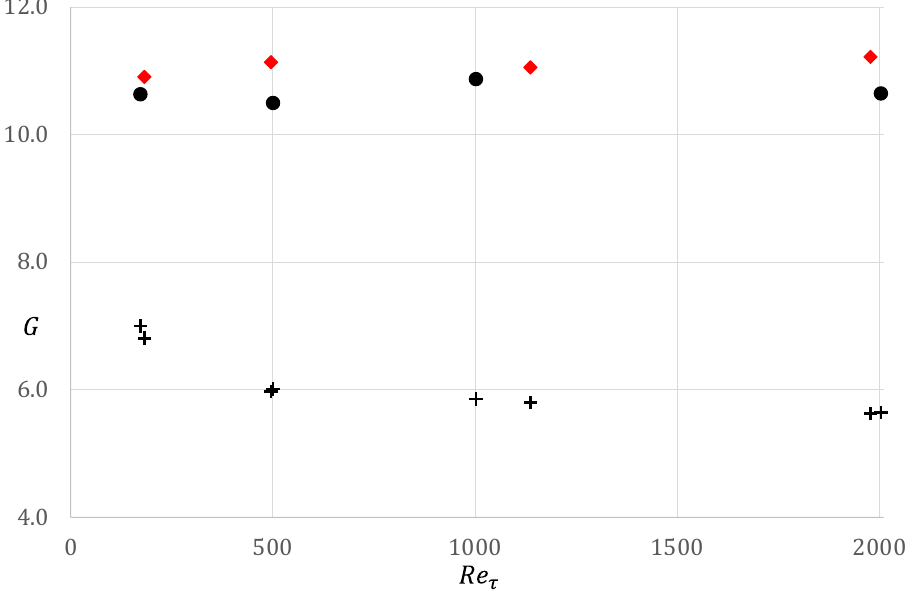
2000 ; • pipe DNS data [26]; pipe DNS data [31,32]; and ♦ 𝐺𝐺